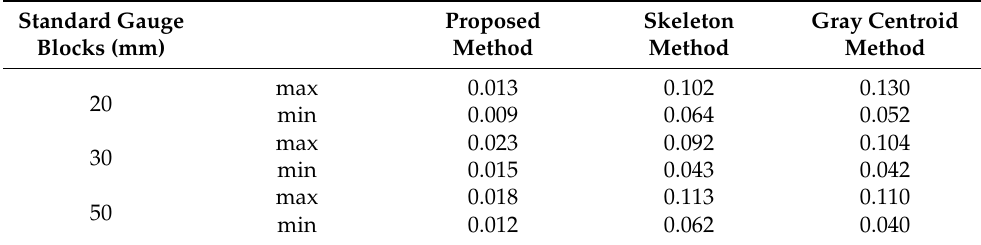
Table 3. The absolute deviation of different methods comparing the standard value (unit: